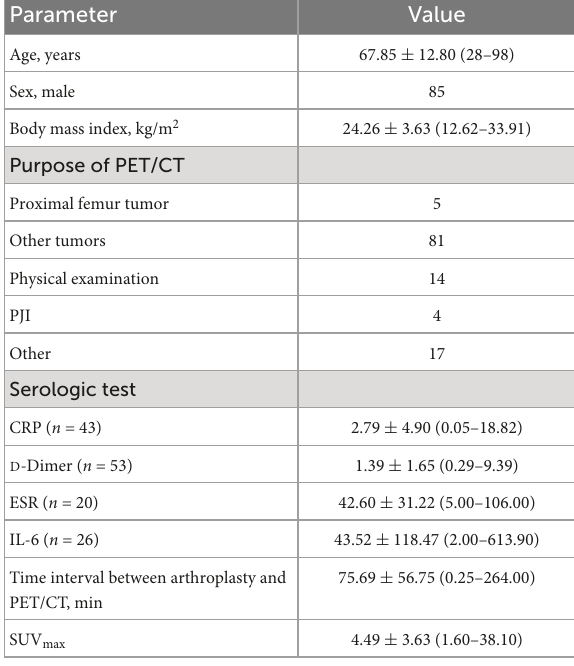
TABLE 1 Clinical data of included